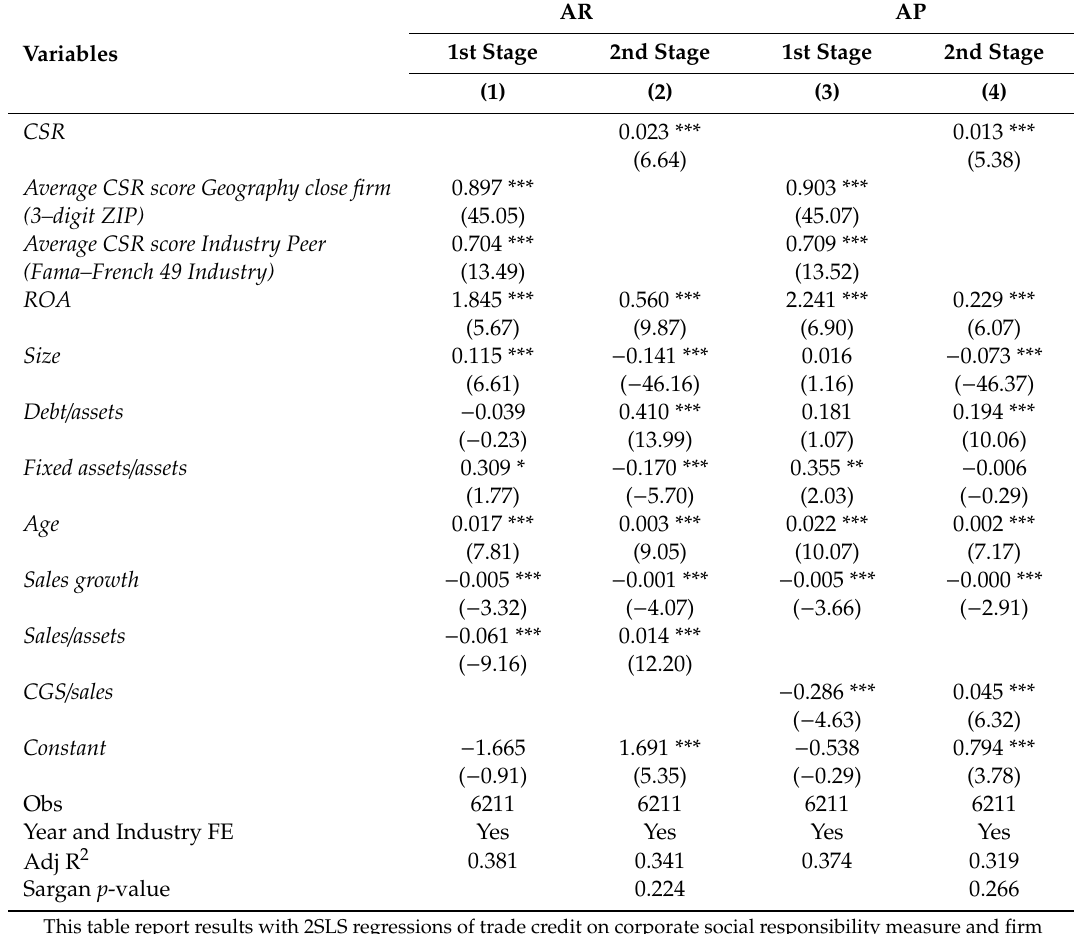
Table 8. Two-stage least squares